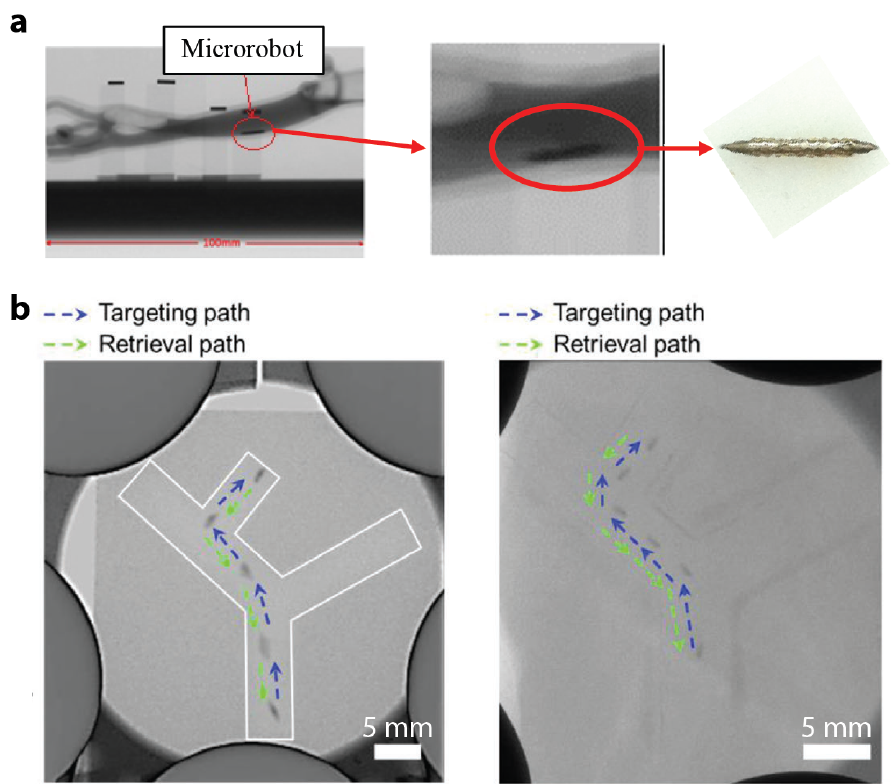
Figure 5. Exemplar studies of small-scale magnetic robotic systems with fluorescence imaging modalities. ( a ) X-ray images of an intravascular microrobot. Reproduced with permission from [93]. Copyright © 2018, CARS. ( b ) Time-lapse X-ray images of a microrobot moving in the 2D vessel phantom with and without a thick layer of pork meat on top of the channel. The white contour is the channel outline. Reproduced with permission from [94]. Copyright © 2021 Wiley-VCH